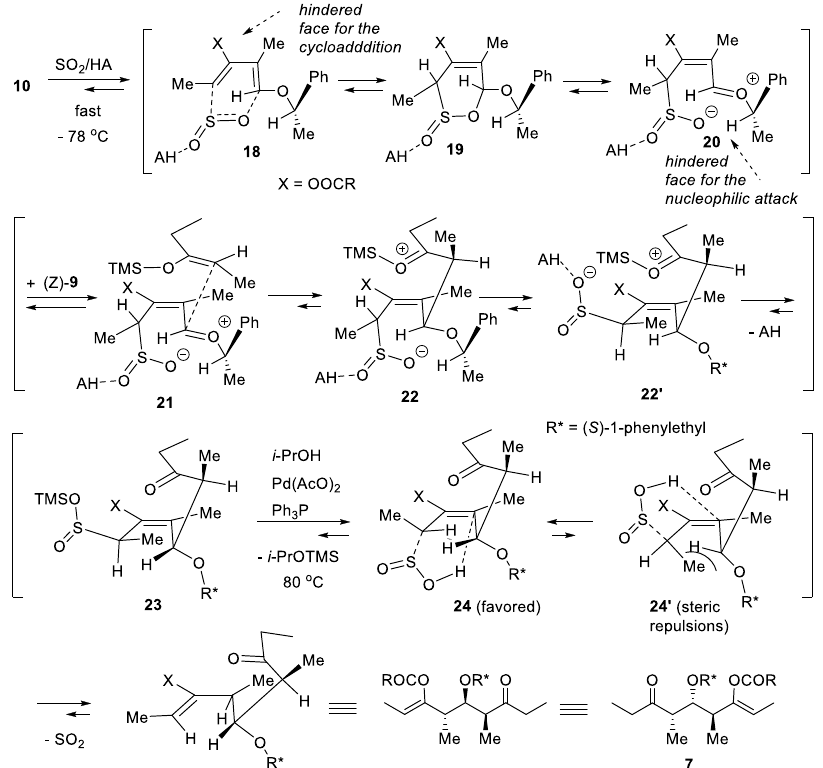
Scheme 3. Proposed mechanism for the reaction cascade producing the syn,anti -stereotriad 7 as major product: (1) face- selective acid-catalyzed hetero-Diels – Alder reaction of SO 2 , (2) immediate ionization of the sultine so-obtained into a zwit- terion, (3) face-selective quenching of the alkoxyallyl cation intermediate by the enoxysilane, (4) intramolecular or inter- molecular silyl transfer forming a silyl sulfinate (can be isolated), (5) its Pd-catalyzed alcoholysis with isopropanol